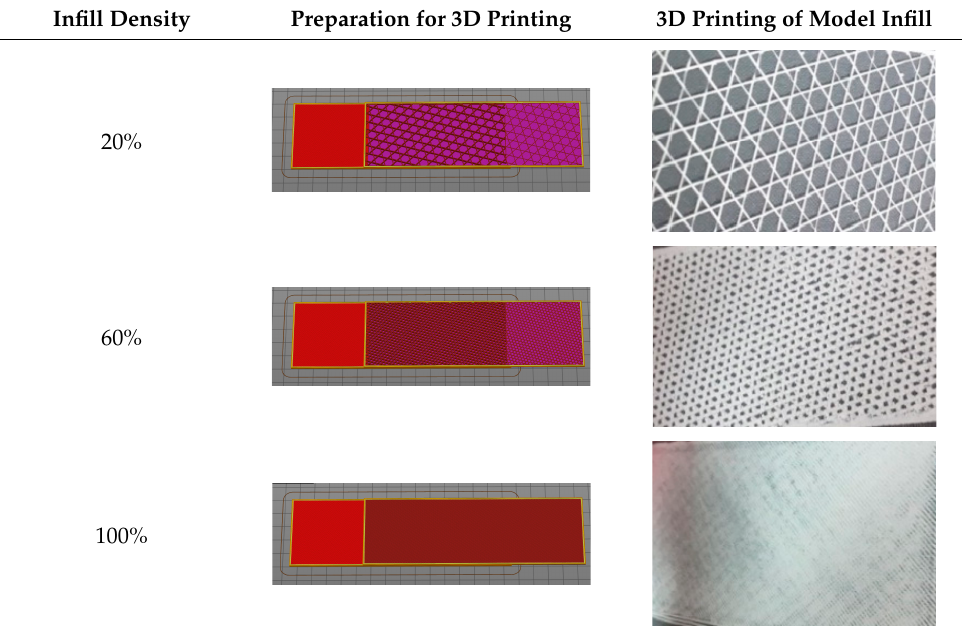
Table 3. Defining 3D printed pattern fillings.